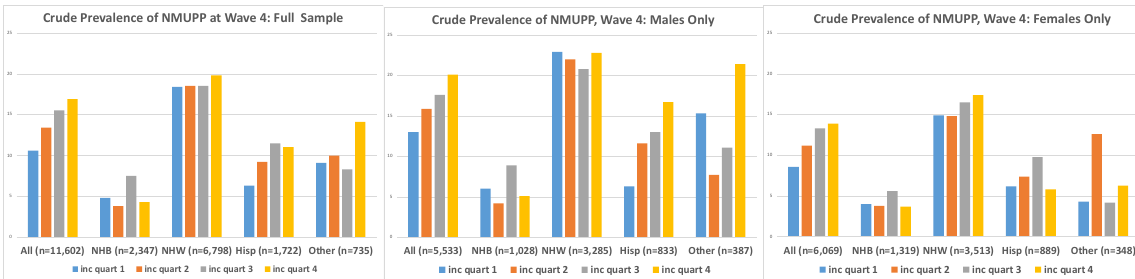
Figure 1. Crude prevalence of NMUPP at Wave 4, by parental income at Wave 1. Note: “W1” = Wave 1; “W4” = Wave 4; “NHB” = non-Hispanic black; “NHW” = non-Hispanic white; “Hisp” = Hispanic. Table 3. Adjusted prevalence (%) reporting prescription painkiller misuse at Wave 4 ( n = 11,602).